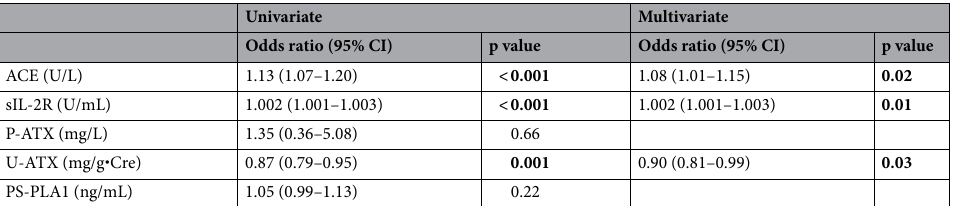
Table 3. Univariate and multivariate logistic regression analysis. Data were analyzed by univariate and multivariate logistic regression analysis. Bold denotes values p < 0.05. Multivariate analysis was performed with ACE, sIL-2R and U-ATX with p < 0.05 in univariate analysis. CI: confidence interval.